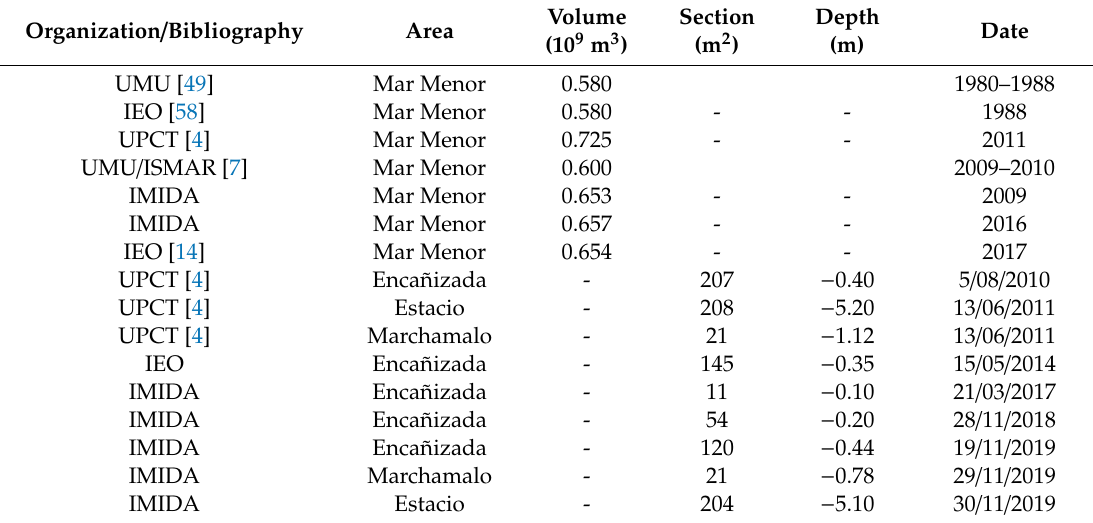
Table 5. The volume of the Mar Menor and characteristics of the exchange